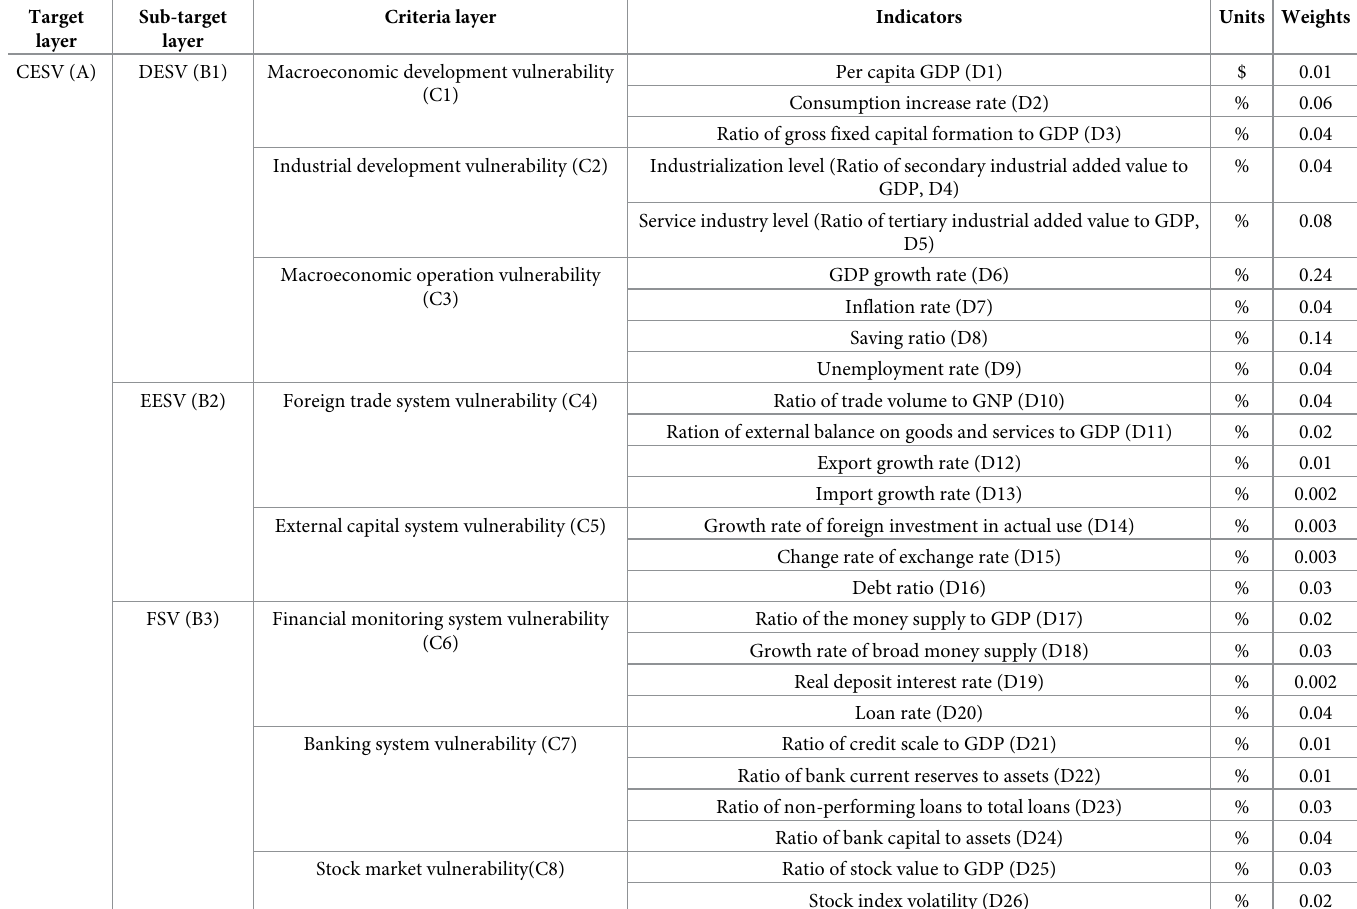
Table 1. Economic system vulnerability evaluation index system for the BRI